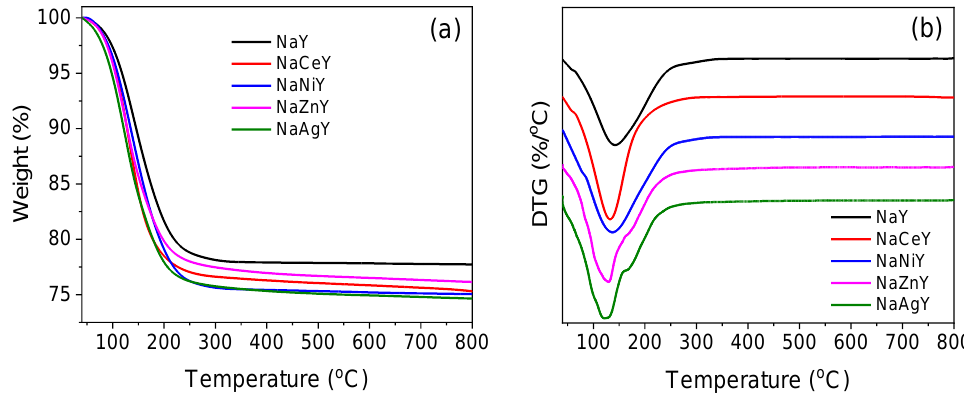
Figure 4. TG ( a ) and DTG ( b ) curves of different Y zeolites.